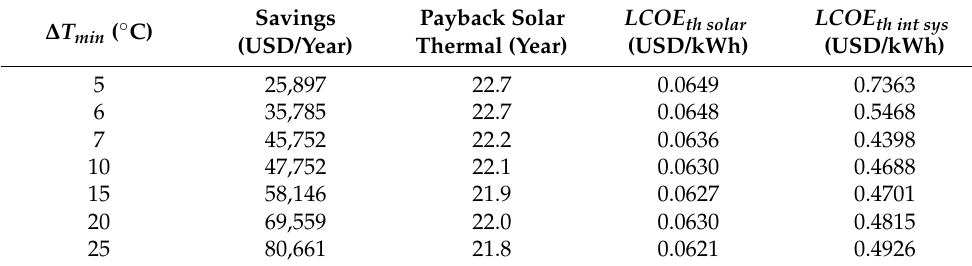
Table 11. Design costs of the solar thermal installation for different ∆ T min